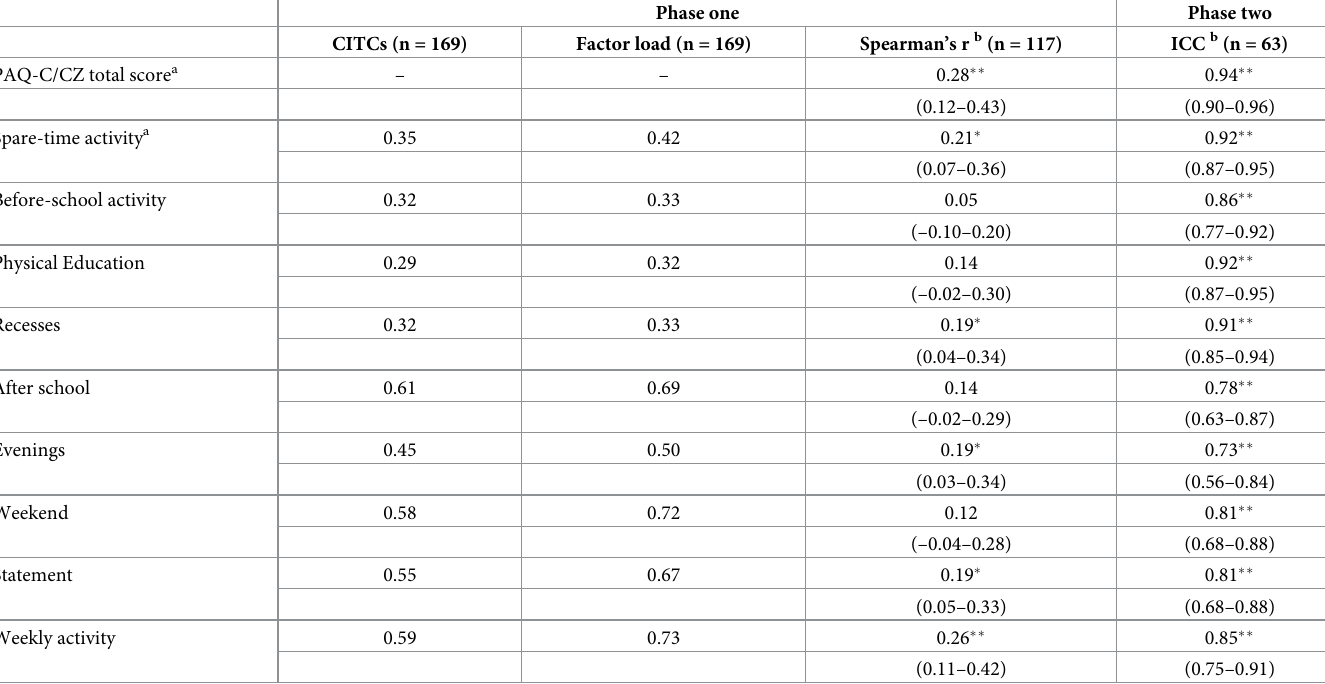
Table 2. Psychometric properties for the PAQ-C/CZ: Item/scale relationship (CITCs), factor loadings, concurrent validity (Spearman’s r), and test-retest reliability